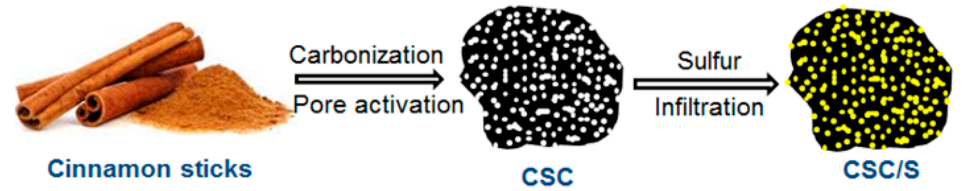
Figure 1. Schematic illustration of the preparation of porous carbon from cinnamon sticks and sulfur infiltration using the melt infiltration method.